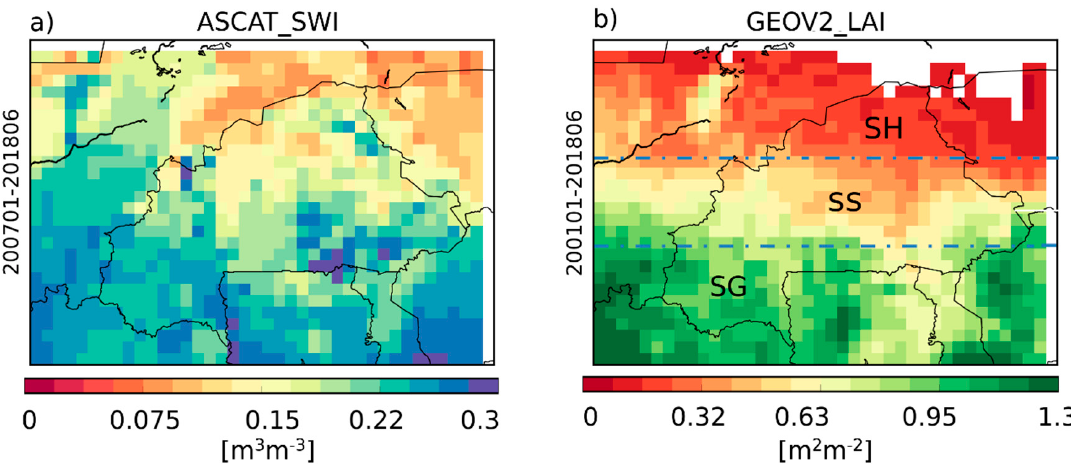
Figure 1. Averaged ( a ) surface soil moisture from ASCAT (obtained after rescaling to model climatology, see Section 2.2.3). ( b ) GEOV2 leaf area index (for pixels covered by more than 90% of vegetation) from the Copernicus Global Land Service project averaged at 0.25° × 0.25° spatial resolution over the domain centred on Burkina Faso (latitudes from 9.0°N to 16.0°N and longitudes from 7.0°W to 3.0°E). The symbols, SH (Sahel), SS (Sudan-Sahel), and SG (Sudan-Guinea), represent the three agroclimatic regions across Burkina Faso (BF).